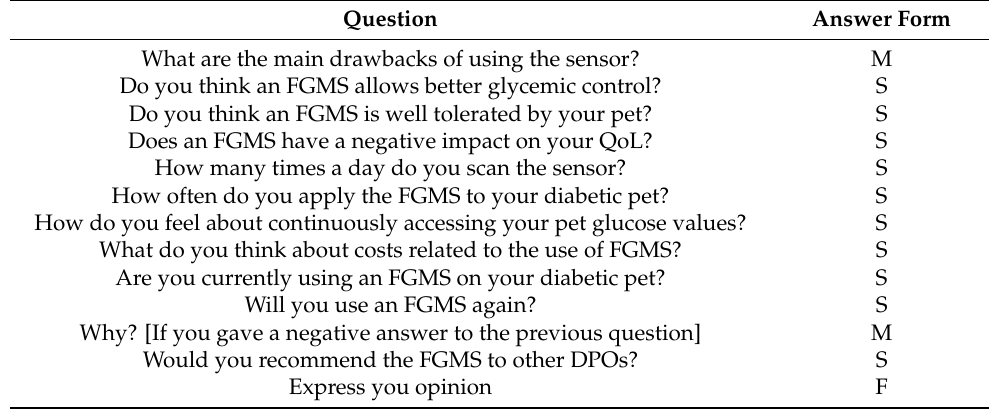
Table 3. Questions related to the impact of a flash glucose monitoring system (FGMS) on the quality of life (QoL) of diabetic pets and diabetic pet owners